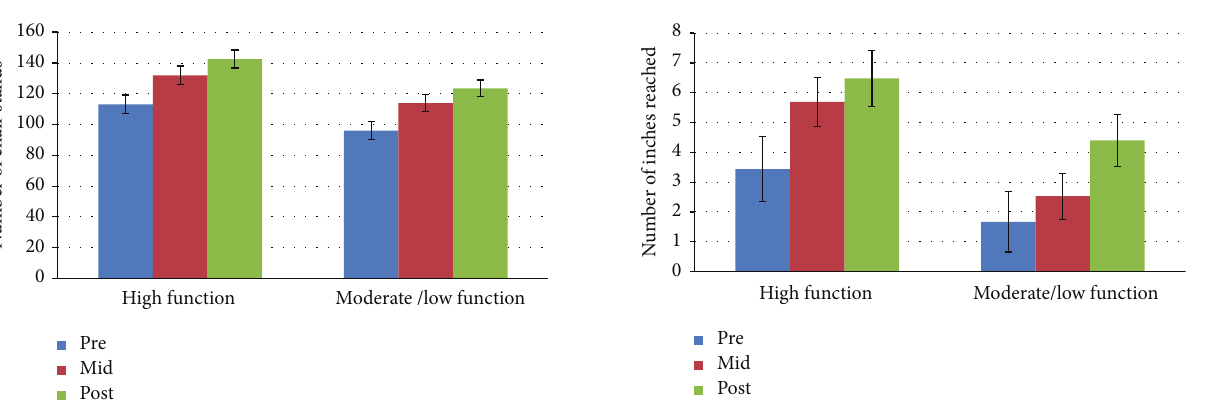
increased between midpoint and posttest with a percent change of 8.4%. There was no significant interaction effect for time ∗ group for the 2-minute step test: 𝐹(2, 50) = 0.032 , 𝑝 = 0.853 , and partial 𝑛 2 = 0.001 at any of the three data collection time points. The main effect of time showed a significant difference in steps at the 3 time points: 𝐹(2, 50) = 14.08 , 𝑝 < 0.0005 , and partial 𝑛 2 = 0.360 . The main effect of group showed a significant difference in steps between physical function groups: 𝐹(1, 26) = 10.71 , 𝑝 = 0.003 , and partial 𝑛 2 = 0.292 .